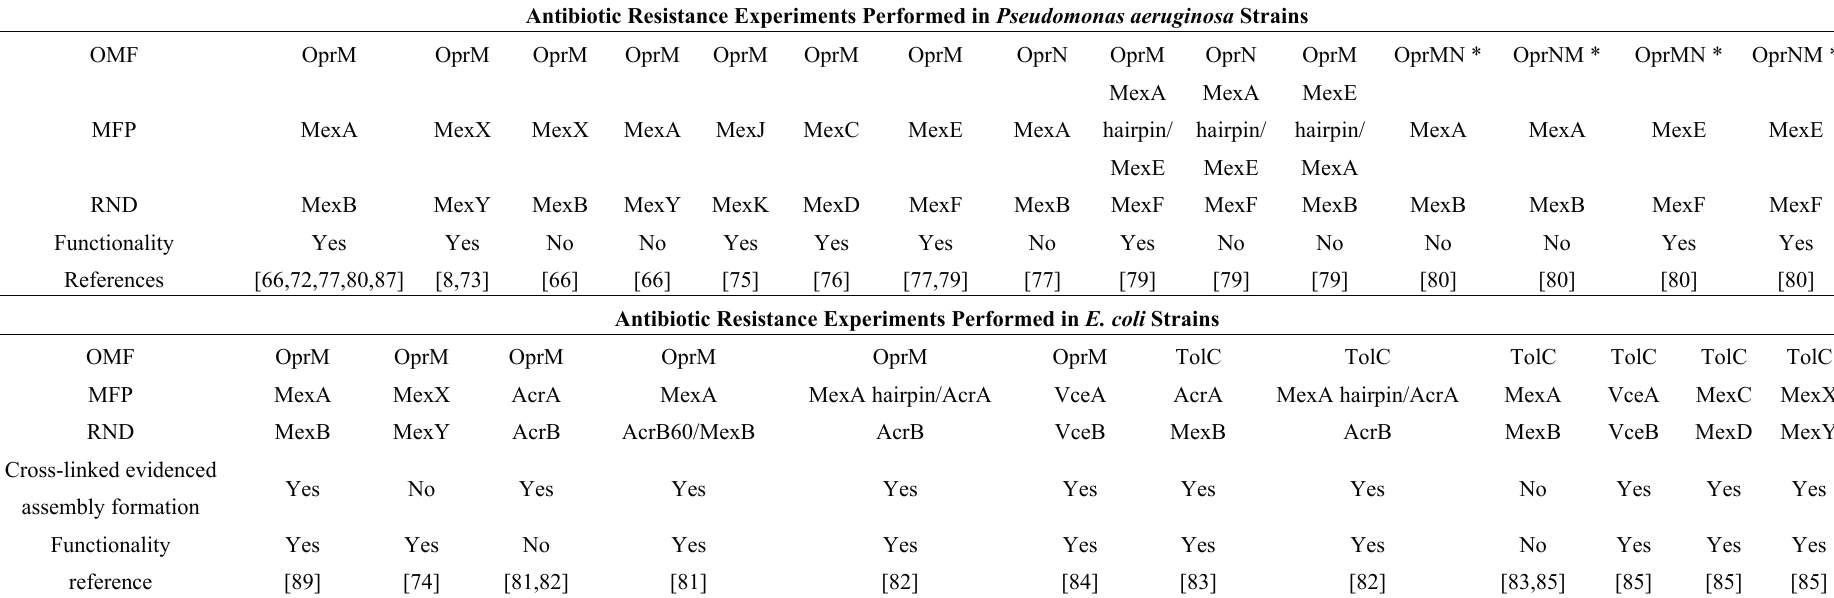
Table 1. Summary of the functional complementarity between different wild-type and mutated proteins forming an efflux pump from different